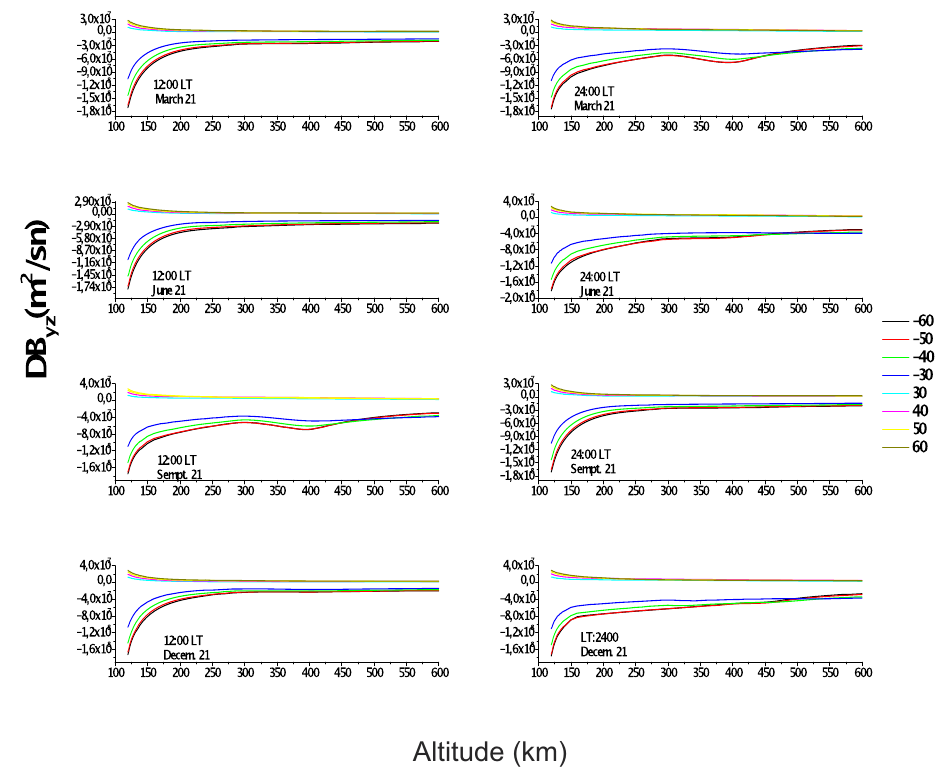
Figure 4. The seasonal diagram of DB